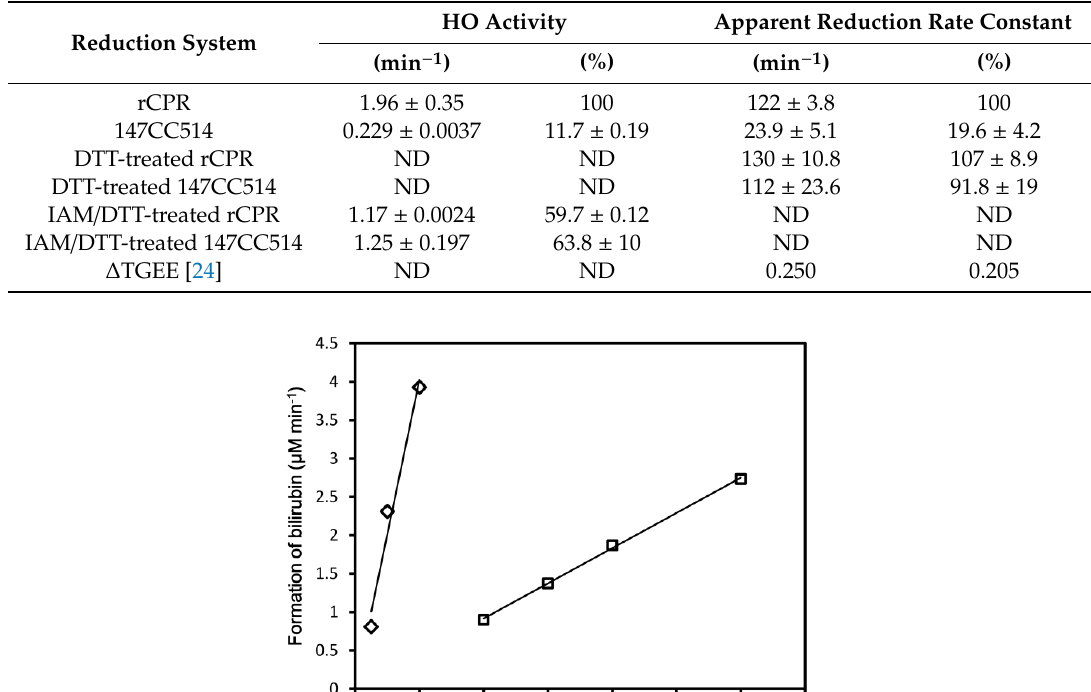
Table 1. Summary of the enzymatic assays. HO, heme oxygenase; rCPR, rat cytochrome P450 reductase; DTT, dithiothreitol; IAM, 2-iodoaceteamide.